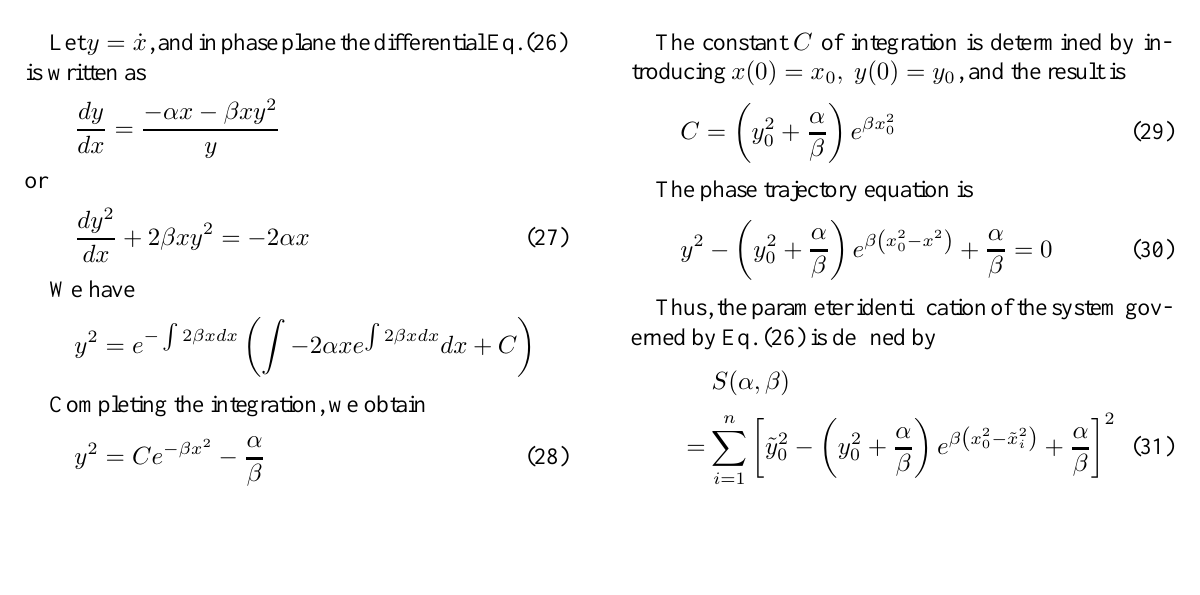
Fig. 2. Phase curve of equation ¨ x + x + 2 x ˙ x 2 = 0